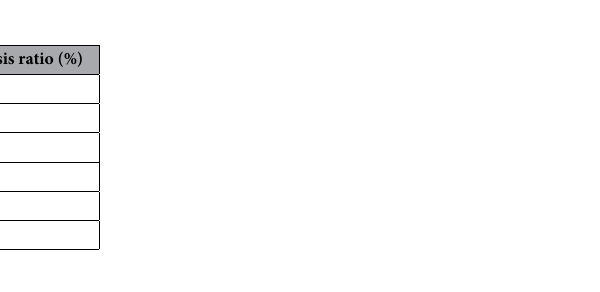
Figure 7. PD conjugates uptake by Eca-109 ( a ) PPa-PD1, ( b ) PPa-PD2, ( c ) PPa-PD3 (d) Cellular uptake. Scale bar 200nm.